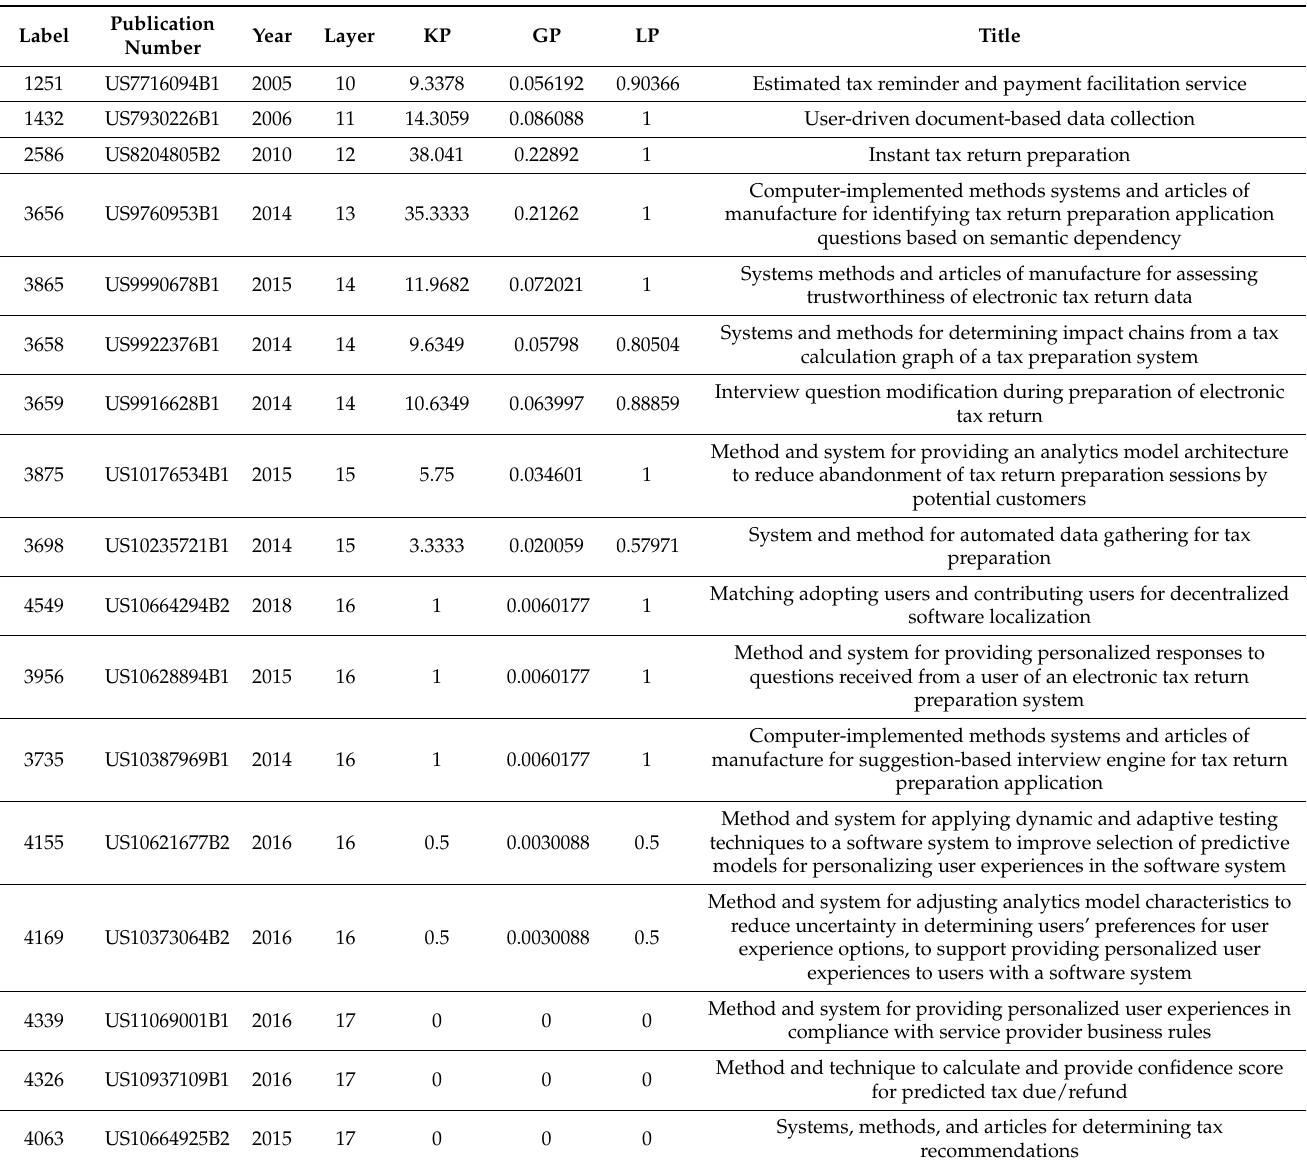
Table 3. List of patents of INTUIT